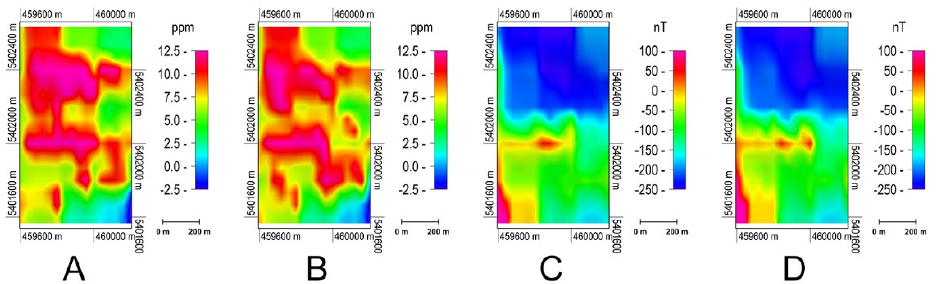
Figure 6. The Reid-Mahaffy test site. Panel ( A ) shows 1068 Hz coaxial component of the observed AEM data. Panel ( B ) shows the same component of AEM data predicted from standalone inversion. The frequency of 1068 Hz is the most sensitive to the conductive mineralization. Panel ( C , D ) show the observed TMI data and those predicted by standalone inversion, respectively.